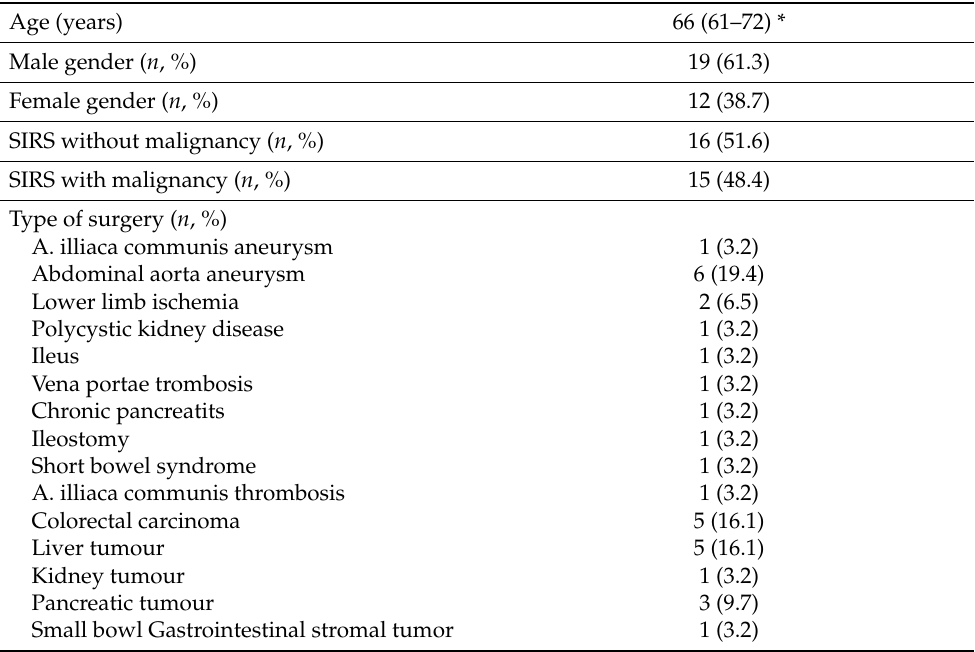
Table 3. Study population characteristics for the SIRS